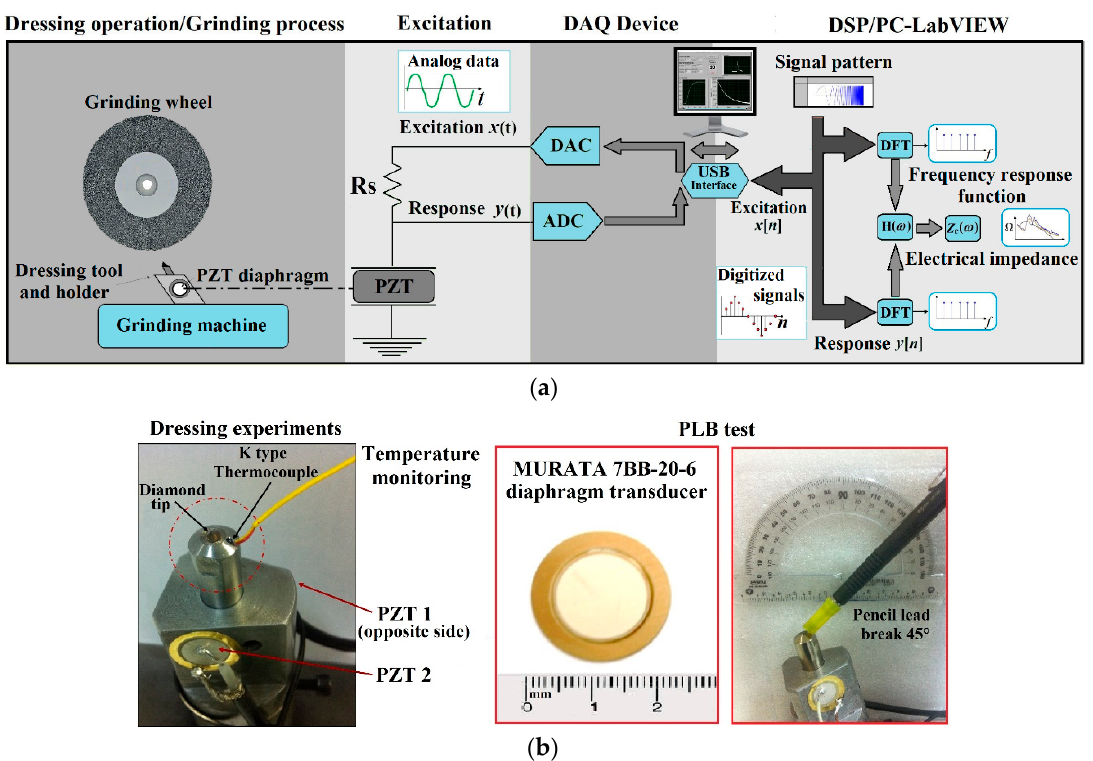
Figure 1. Proposed sensing setup for dressing tool condition monitoring: ( a ) EMI technique-based system; and ( b ) dressing experiments and PLB setup.